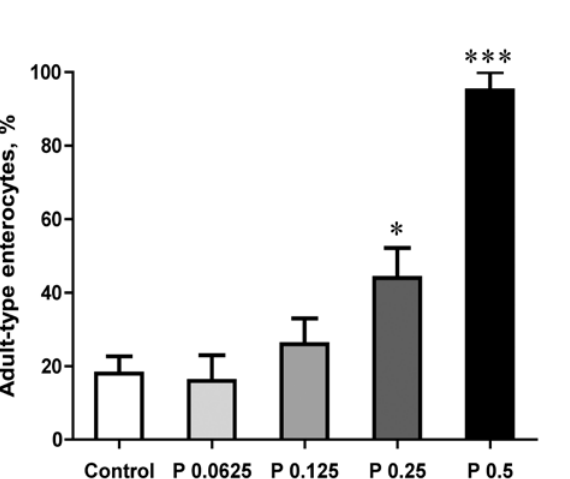
Fig 4. Increased maturity of the small intestinal epithelium of 17 d-old rats, as shown by the portion of adult-type enterocytes, lacking supranuclear vacuoles, appearing on the villi in the distal small intestine after gavage feeding with increasing doses of a microbial-derived protease (P 0.0625, 0.125, 0.25, 0.5 mg per gram body weight) or water (control) during 14 – 16 days of age. Statistically significant differences between control and enzyme-treated group (mean ± SD, n = 5 – 6) is indicated by * P < 0.05, *** P < 0.001.